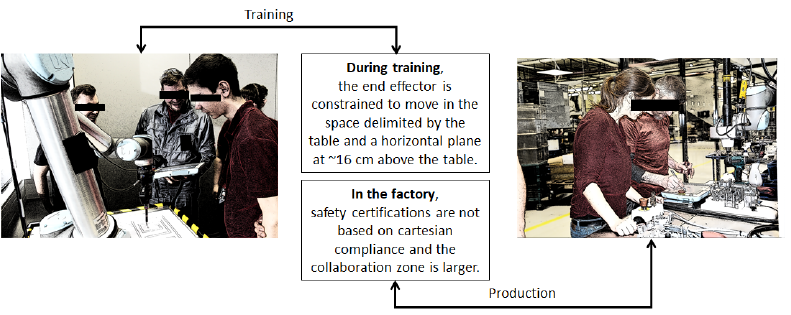
Figure 10. Edubot scenario: Universal Robot (UR) 10 collaborative robot used for education and training purposes in a manufacturing company with trainer and trainees [53,54].